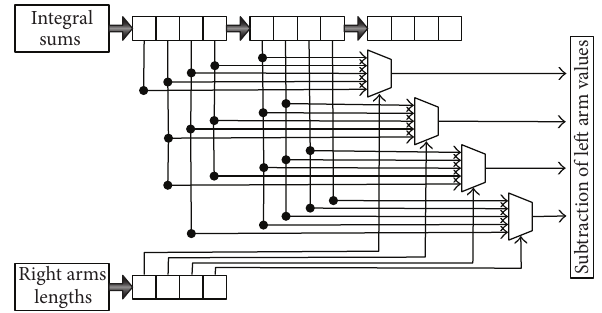
Figure 10: Illustration of right arm part of HorDiff for a maximum arm length of 5 (multiplexer size) and an unrolling factor 𝑓 𝑢 of